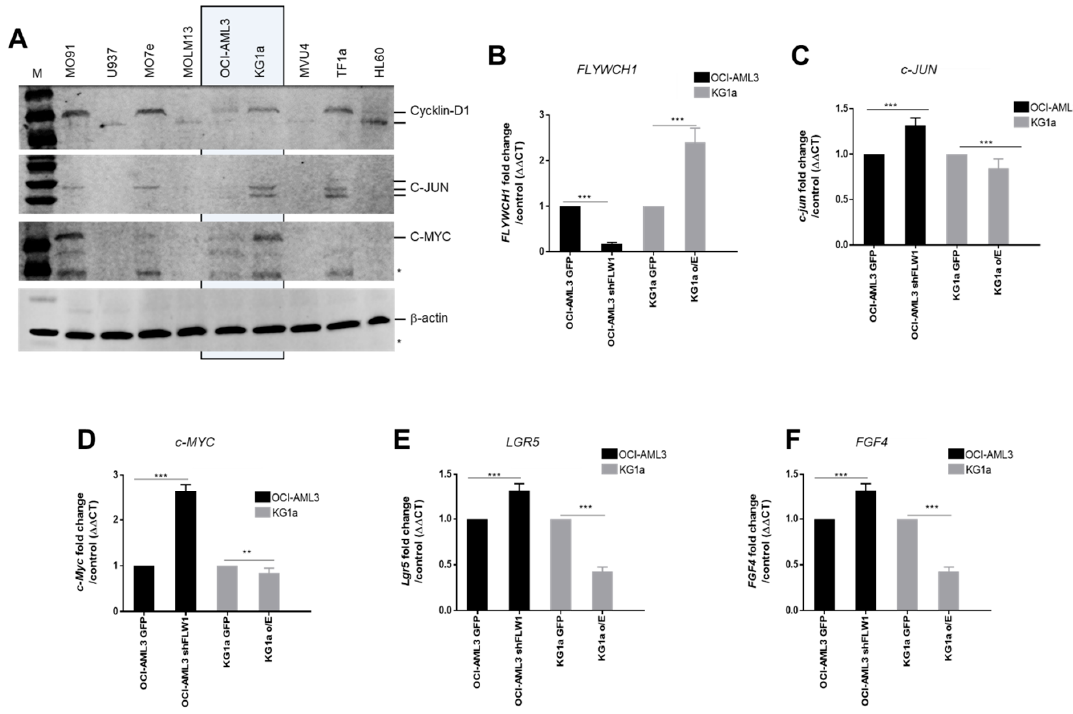
Figure 3. FLYWCH1 regulates certain β -catenin / TCF4 target genes involved in the AML. ( A ) Western blot analysis of β -catenin target gene expression in AML cell lines using antibodies against cyclin D1, c-Myc, c-Jun, and β -actin loading control. Asterisks ( ∗ ) indicate unspecific bands. ( B – F ) Effect of ( B ) FLYWCH1 gene expression modulation on: ( C ) c-JUN , ( D ) c-MYC , ( E ) LGR5 , and ( F ) FGF4 transcription activity. Data are mean ± SD ( n = 6; * p < 0.05; ** p < 0.01; *** p < 0.001).